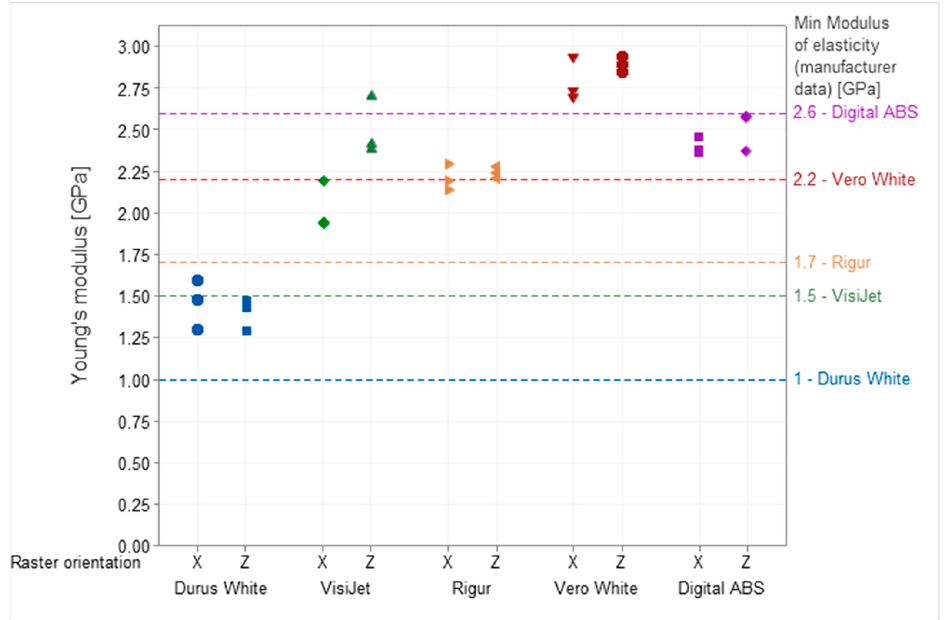
Figure 7. Young’s modulus was obtained during the test for Durus, VisiJet, Rigur, Vero, and ABS materials.